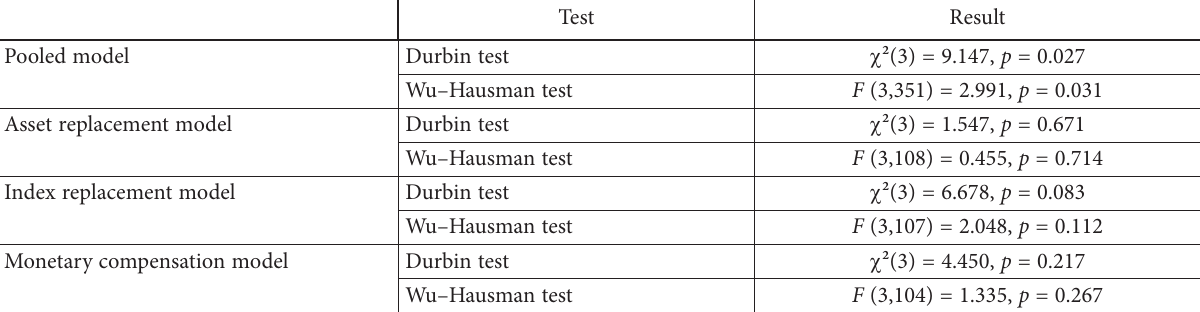
Table 4. Durbin and Wu–Hausman test for endogenous detection